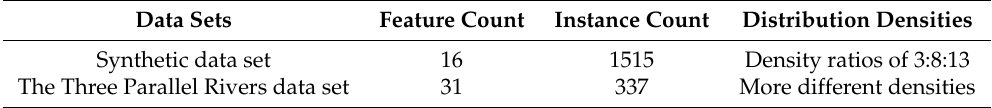
Table 1. The distributions of features and instances in the experimental data